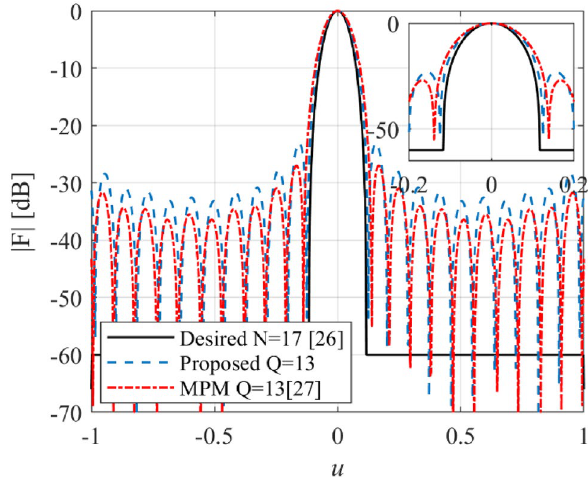
Figure 2. The synthesized results of Kumar and Branner.